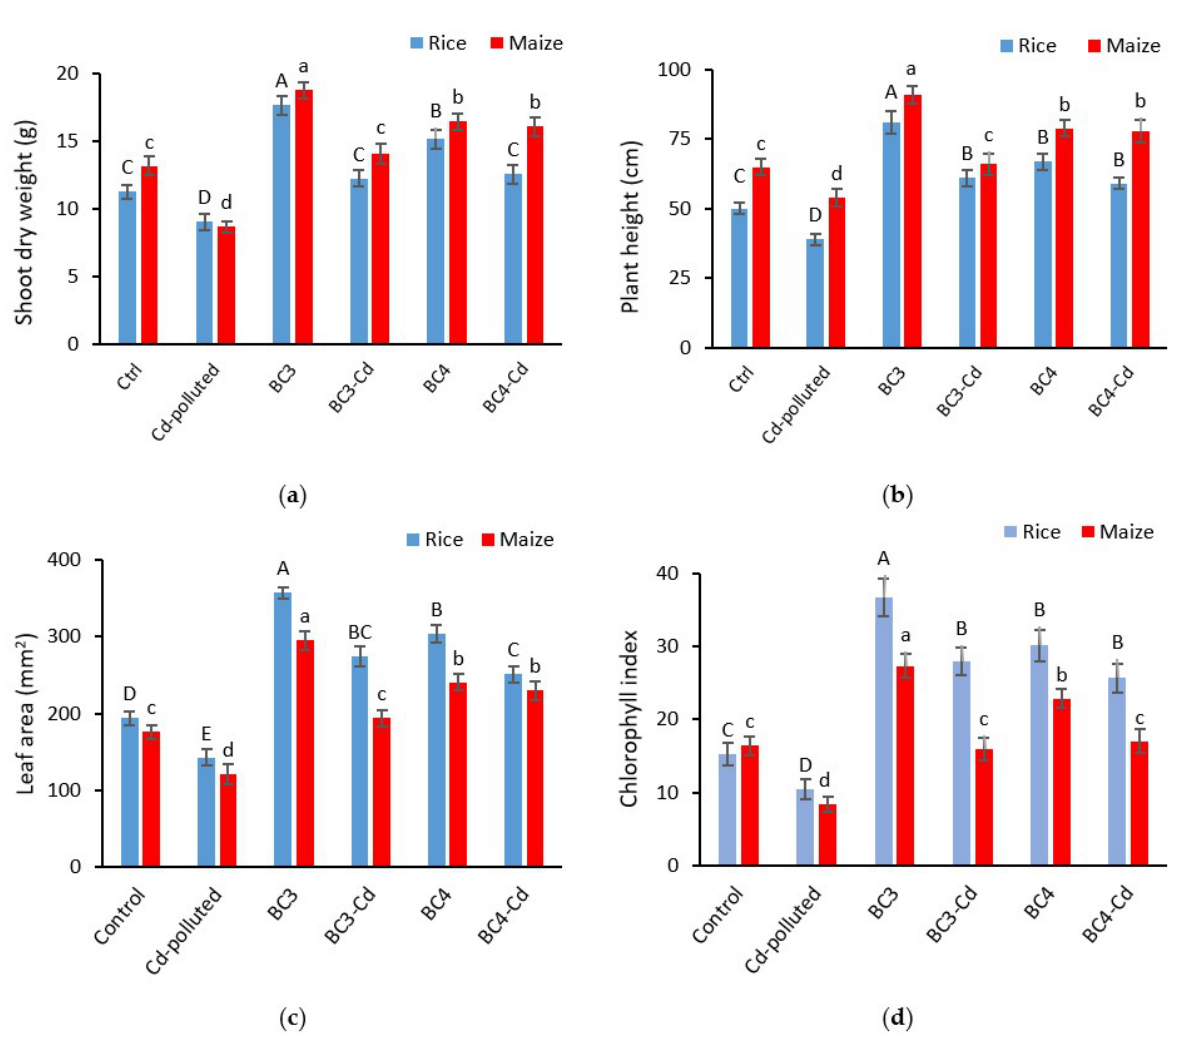
Figure 1. Influence of biochar and Cd treatments on shoot weight ( a ), plant height ( b ), leaf area ( c ), and chlorophyll index ( d ) in rice and maize fields as representatives of C3 and C4 plants, respectively. Significant differences of means are shown by different uppercase letters for rice and lowercase letters for maize ( p < 0.01). The values are means ± SD from three replicates (n = 3). BC3: rice biochar, BC4: maize biochar, BC3 + Cd: rice biochar + cadmium, and BC4 + Cd: maize biochar + cadmium.